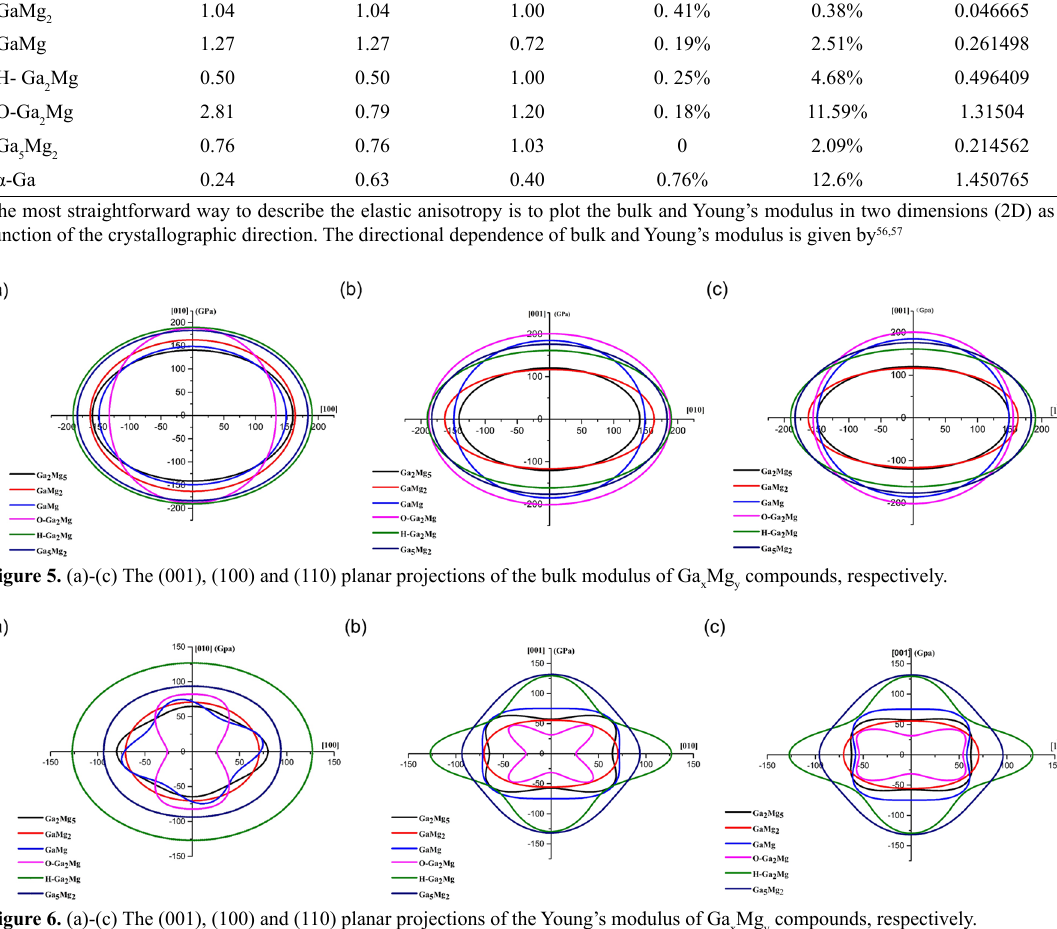
and A ) and shear anisotropic factors (A B G